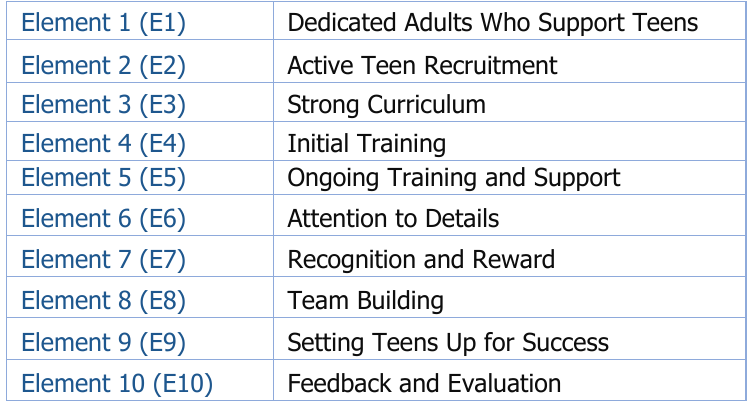
Table 2. Ten Essential Elements of Teens as